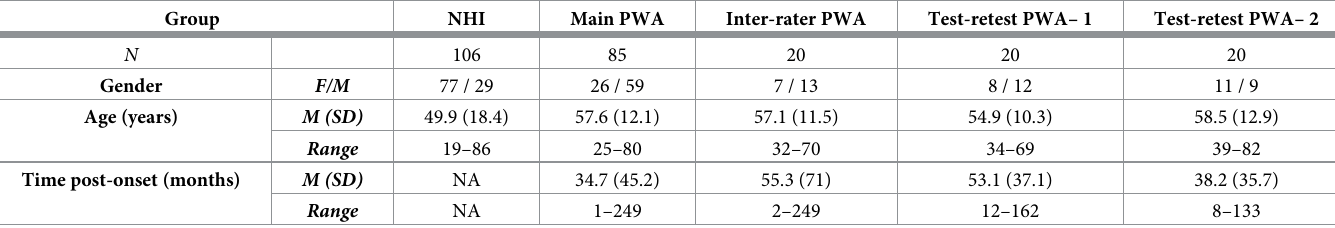
Table 1. Participants’ demographic